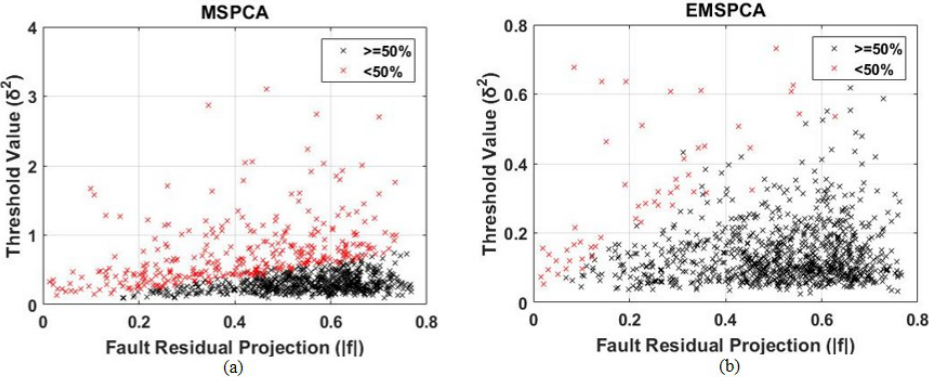
Figure 8. Scatter plot analysis of the relationship between threshold value and fault projection for MSPCA ( a ) and EMSPCA ( b ) for 50% success rate; depth of 4, a fault magnitude of 1 sigma, 1000 MC